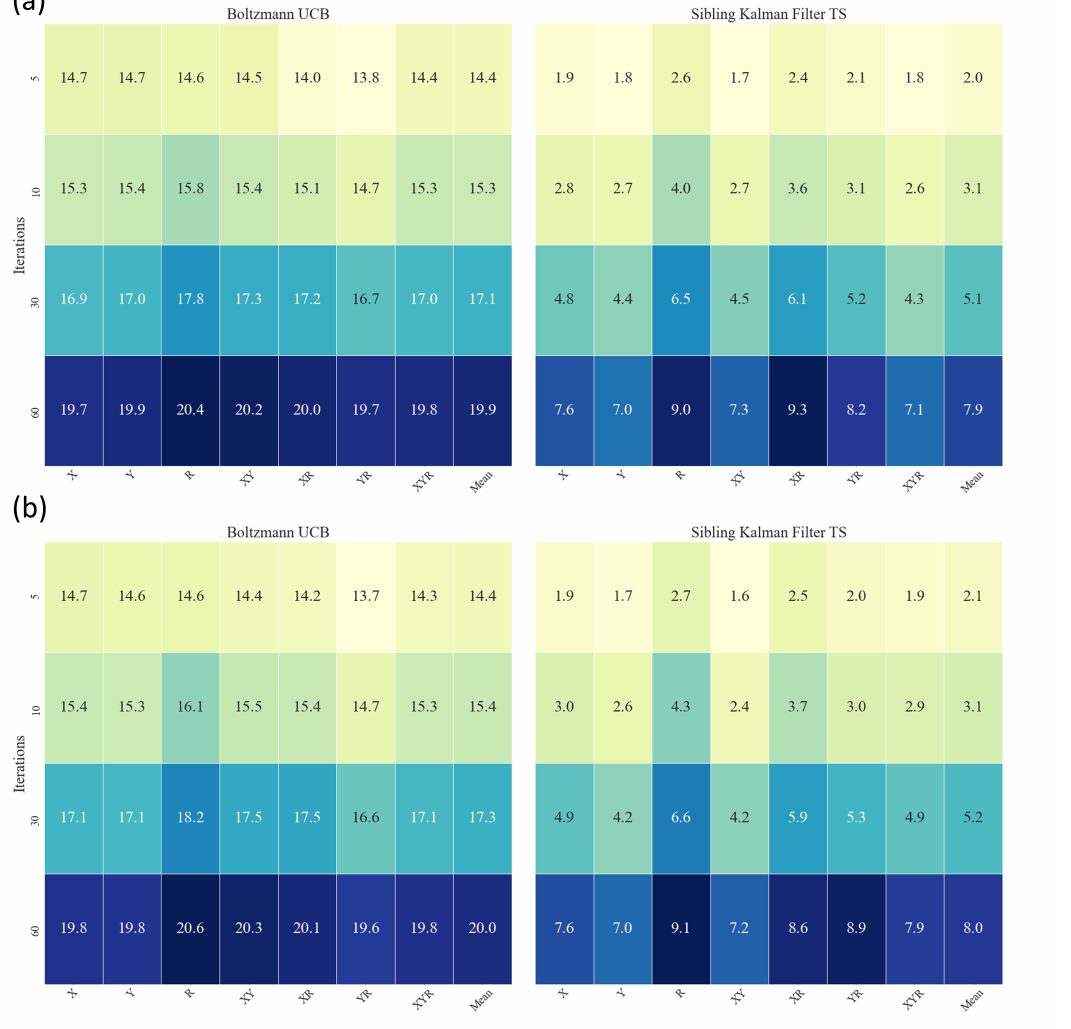
Figure 5. MAB Heatmap showing the results for UAAE ( a ) and for SSAAE ( b ) at iterations 5, 10, 30, and 60 for Boltzmann UCB (left) and Sibling Kalman Filter with Thomson Sampling (right) for each database (X, Y, R, XY, XR, YR,